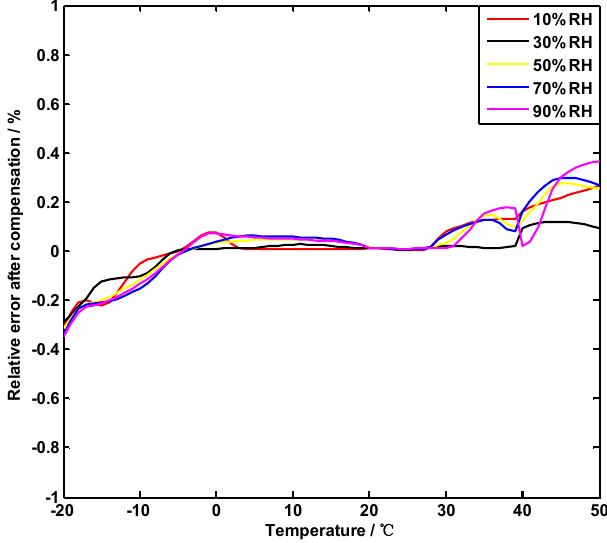
Figure 8. Compensation curve of GSA-BP neural network.